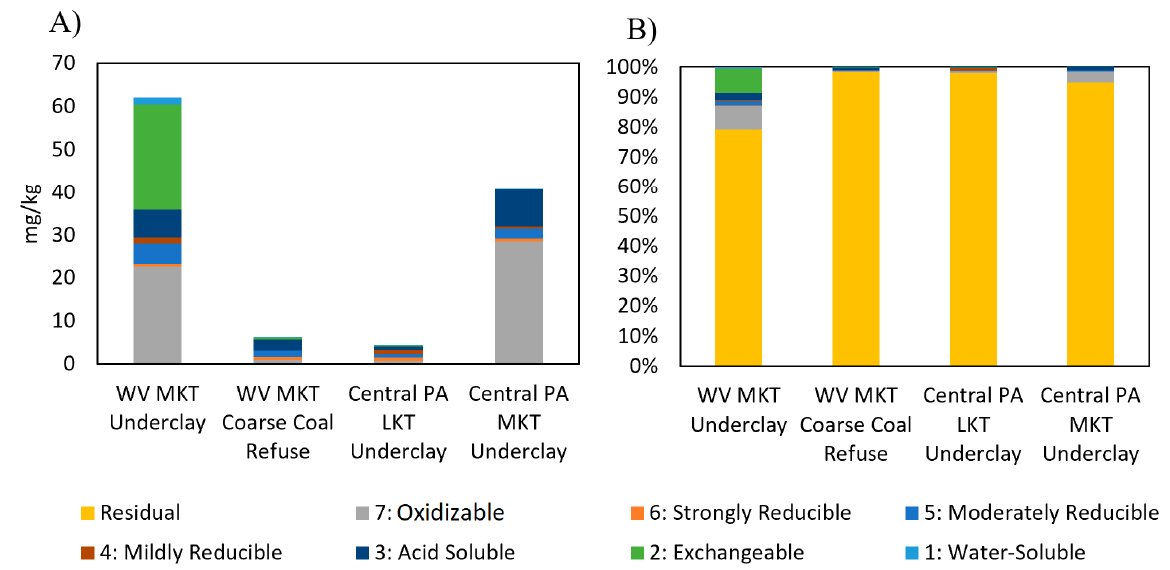
Figure 6. ( A ) Distribution of REE from sequential extractions excluding the residual fraction. ( B ) Plot of REE distribution from sequential extractions normalized to percentage extraction.